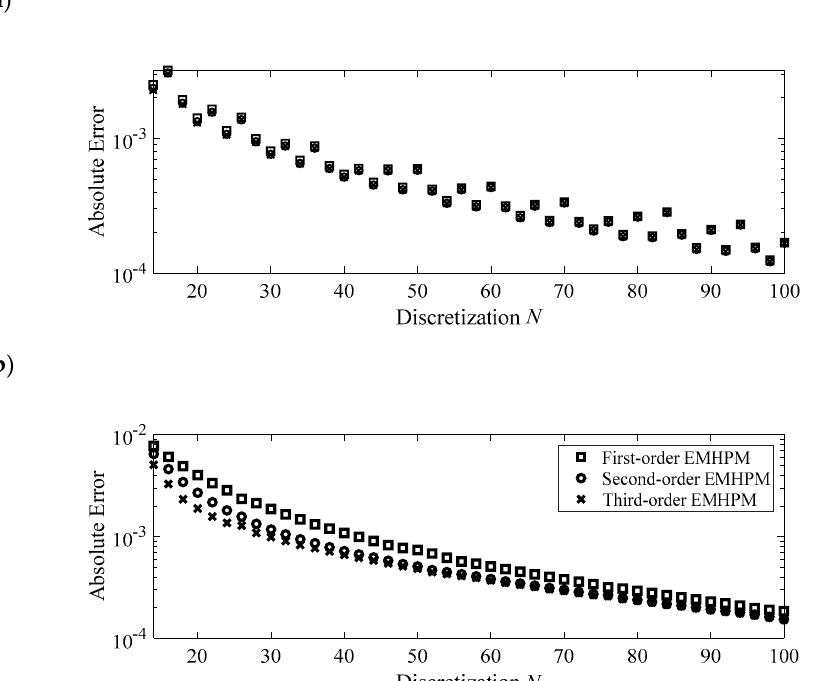
Figure 3. Convergence rate of absolute error between first-, second- and third-order EMHPM for down-milling operation. Cutting parameters for ( a ) a p = 1.5 mm, a d = 1 and n = 12,000 rpm and ( b ) a p = 3 mm, a d = 1 and n = 12,000 rpm .